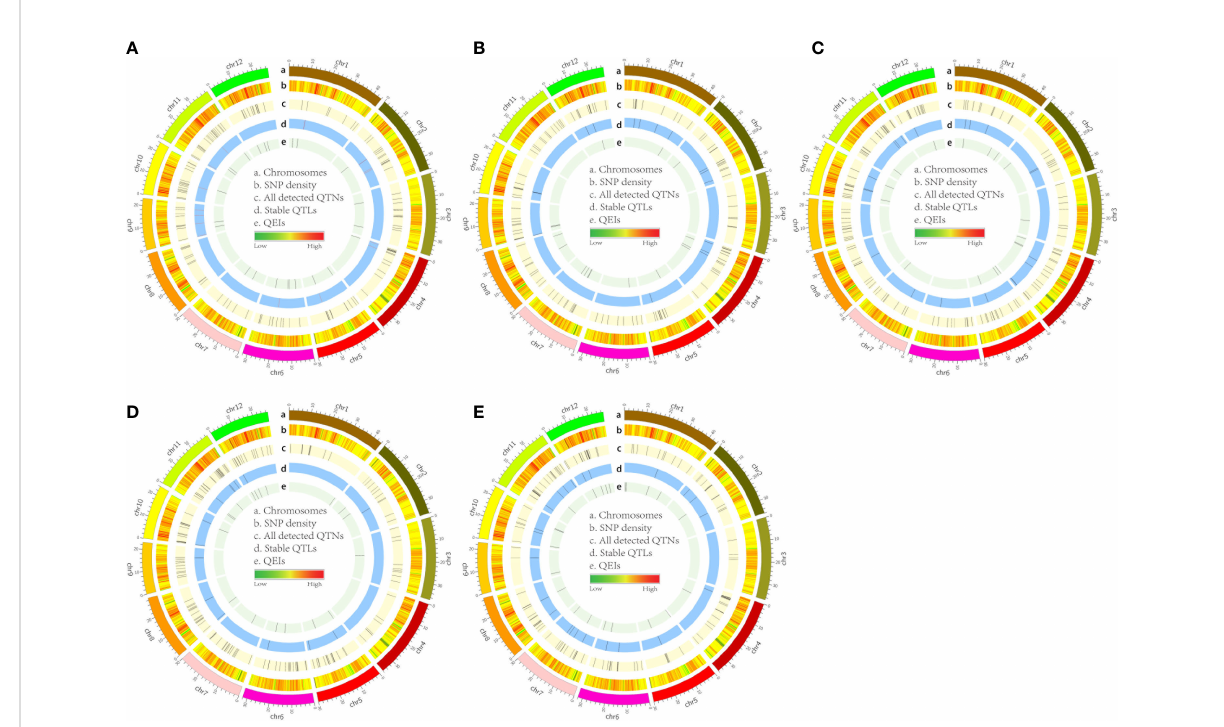
FIGURE 3 Circos map of QTLs and QEIs in rice genome identi fi ed from Val (A) , Leu (B) , Ile (C) , Arg (D) , and Trp (E) datasets. Track A: 12 rice chromosomes; Track B: heatmap of SNP density with bin sizes of 0.1 Mb; Track C: total unique QTNs detcted by all used methods; Track D: stable QTLs co-detected by no more than two methods; Track E: all detected QEIs by the 3VmrMLM